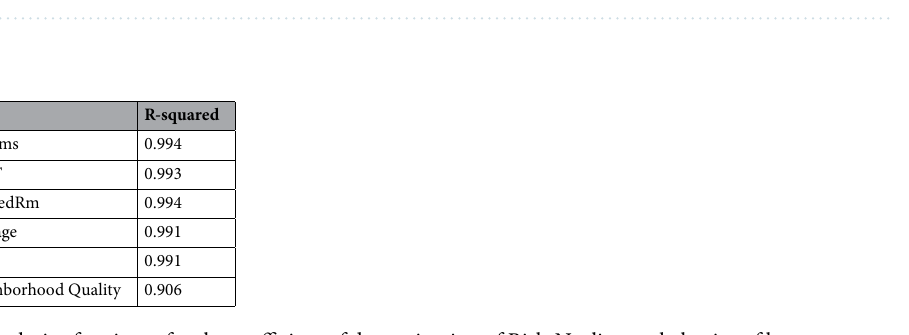
Table 2. Analysis of variance for the coefficient of determination of Risk-Negligence behavior of buyers.